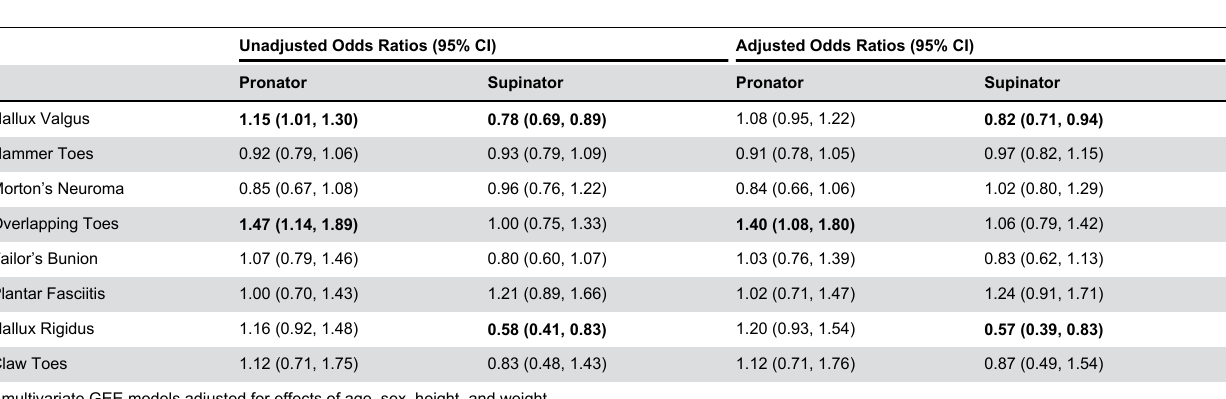
Table 3. Unadjusted and adjusted* odds ratios and 95% confidence intervals (CI) for relation of specific foot disorders and foot function defined by center of pressure excursion index